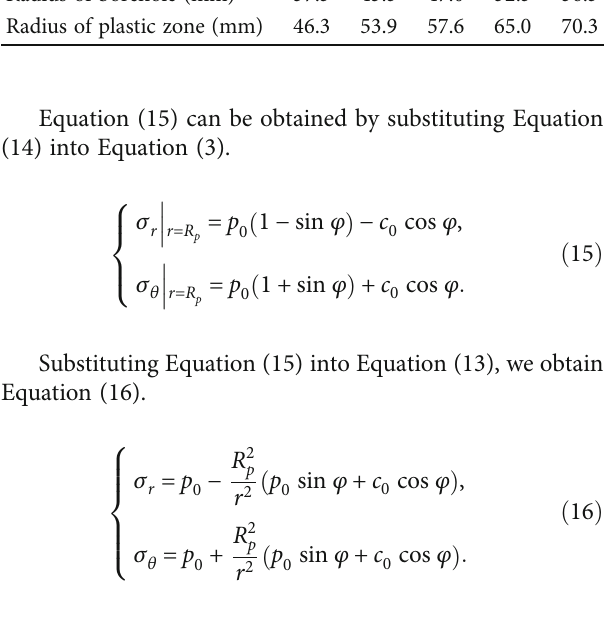
Table 2: Radii of the simulated plastic zones of boreholes with di ff erent pore sizes. Radius of borehole (mm) Radius of plastic zone